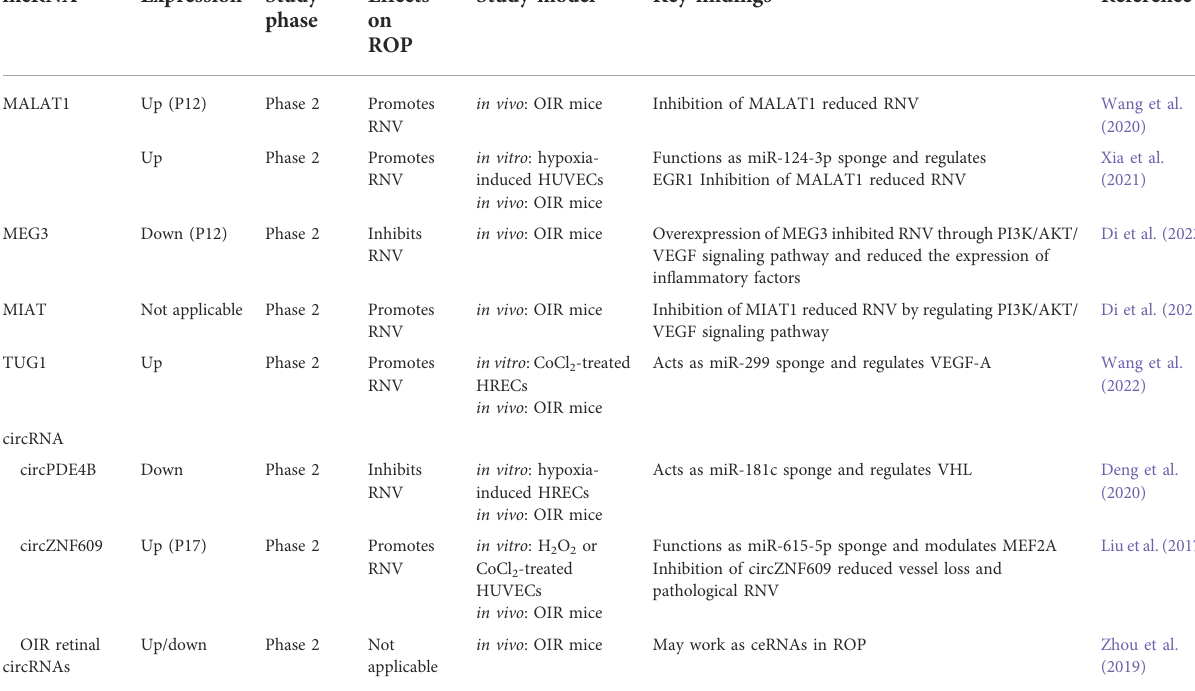
TABLE 2 long noncoding RNAs and circular RNAs regulating retinopathy of prematurity (ROP).